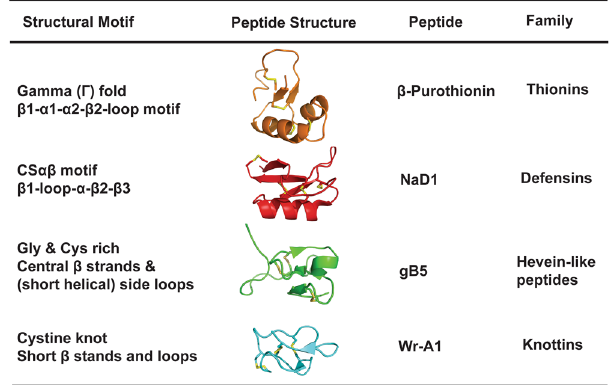
Figure 1. List of major plant CRP families with representative member within the chemical space of 2–6 kDa can be arbitrarily classified into two major groups. Plant thionins and defensins contain α -helix in their structural motif while hevein-like peptides and knottins contains a majority of β -strands. (PDB ID: 1BHP, 4AB0, 5XIV,